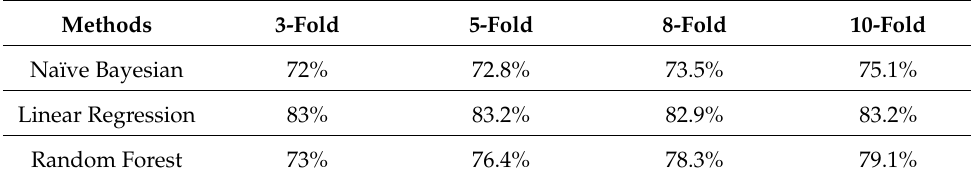
Table 4. K-Fold validation method results by applying TF-IDF